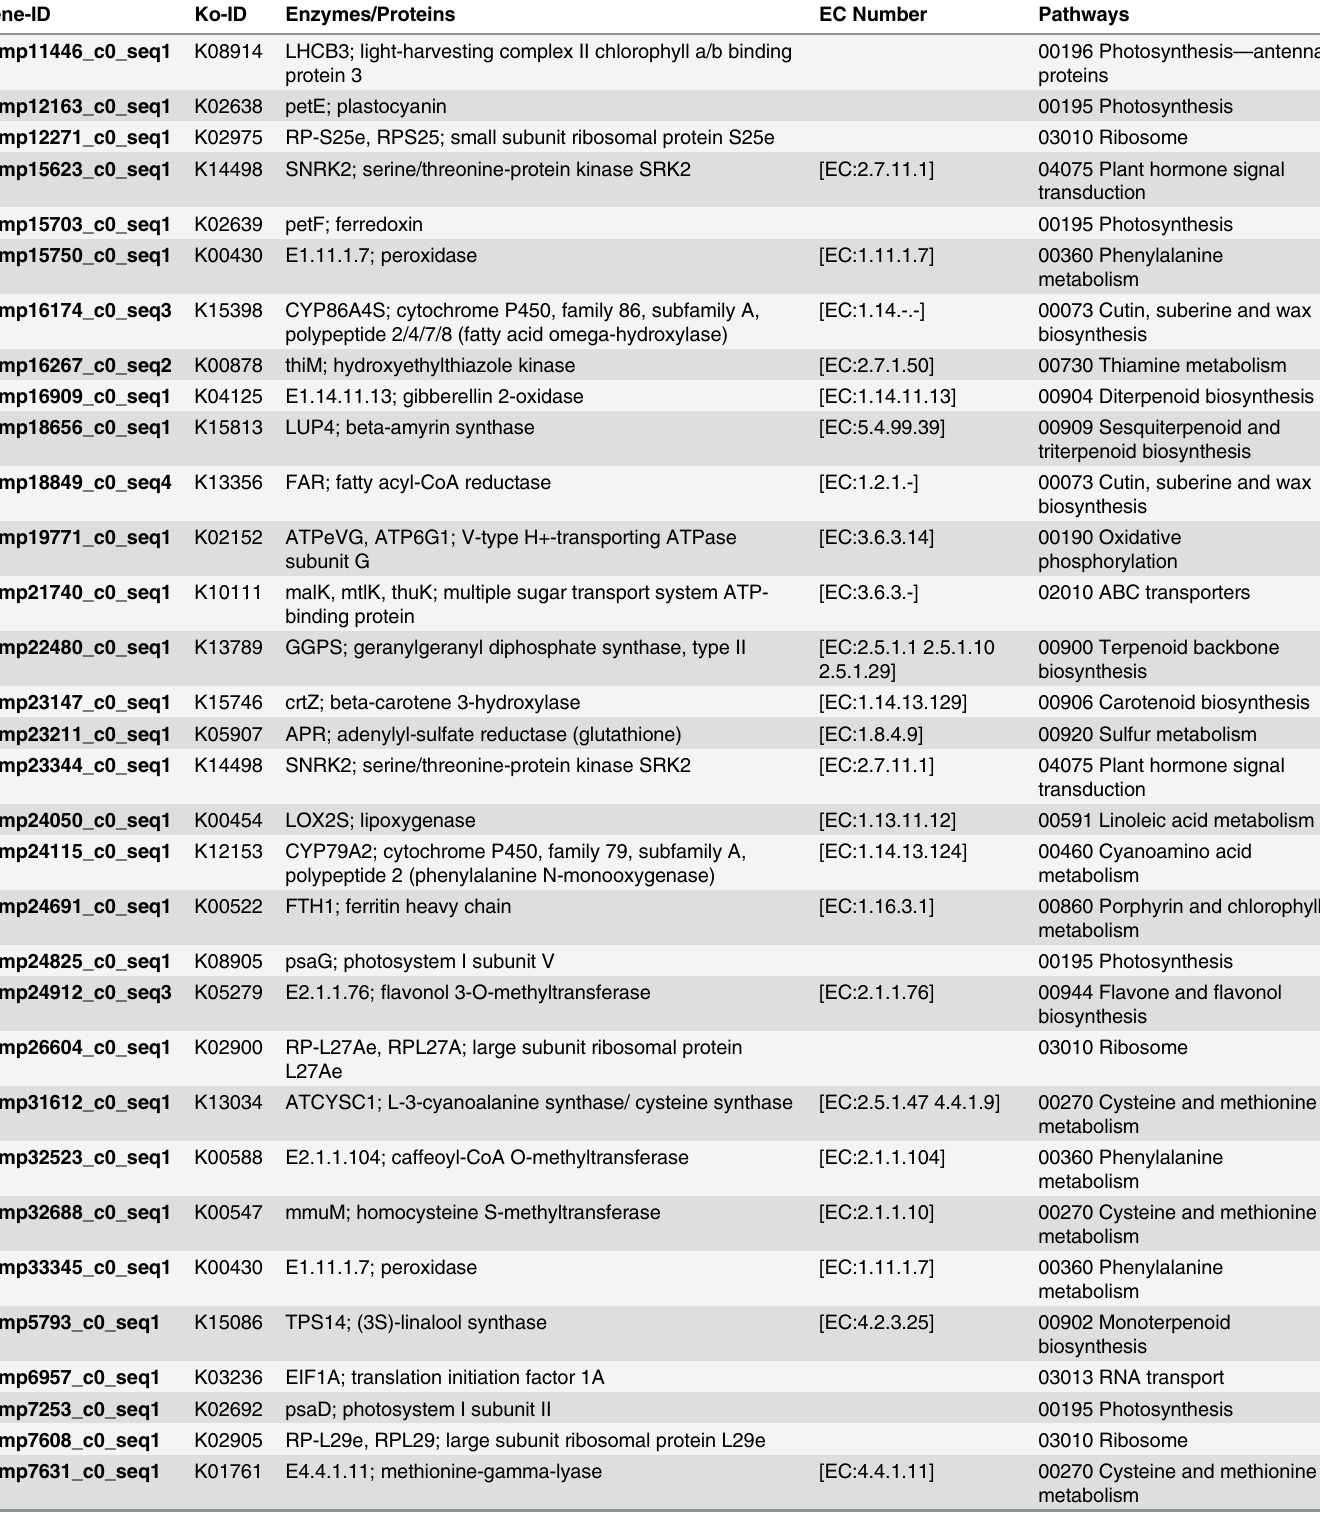
Table 2. The Xanthoceras sorbifolium selfed ovule specifically or preferentially expressed genes were annotated to BRITE functional hierarchies.